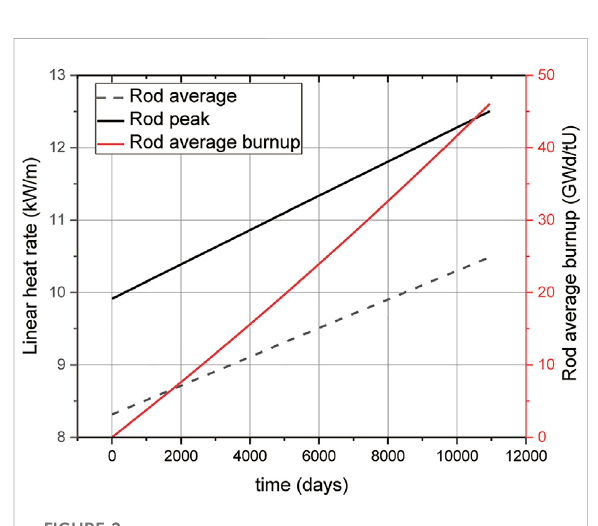
FIGURE 2 Average burn-up and linear heating rate pro fi le of the rod.